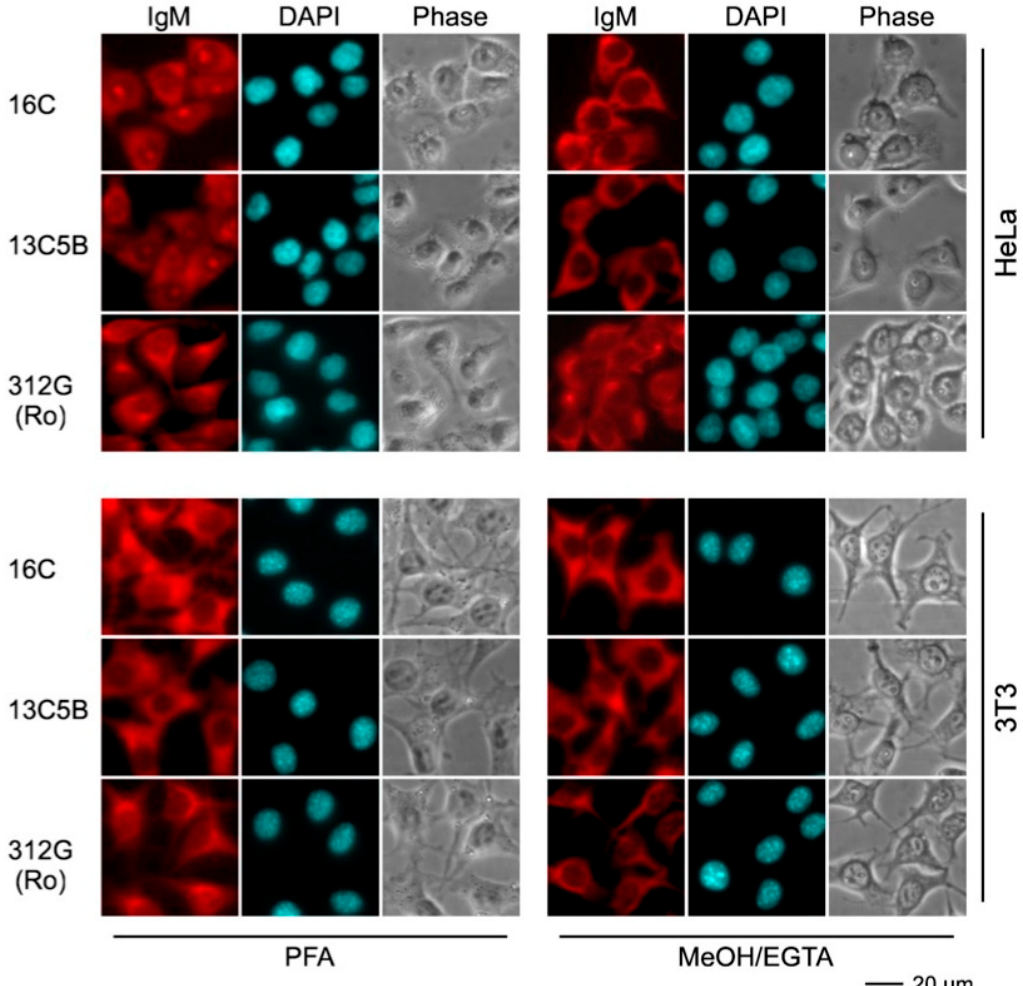
Figure 10. Epifluorescence microscopy of human HeLa cells and mouse 3T3 stained with anti-La IgM mabs. Prior to the staining, cells were fixed with either paraformaldehyde (PFA) or methanol (MeOH)/EGTA. For detection of the primary anti-La mabs (16C, 13C5B) or the anti-Ro mab (312G), we used an anti-mouse-IgM antibody conjugated with Alexa Fluor ® 568 as secondary ab. DNA was stained with DAPI. Phase, phase contrast image.